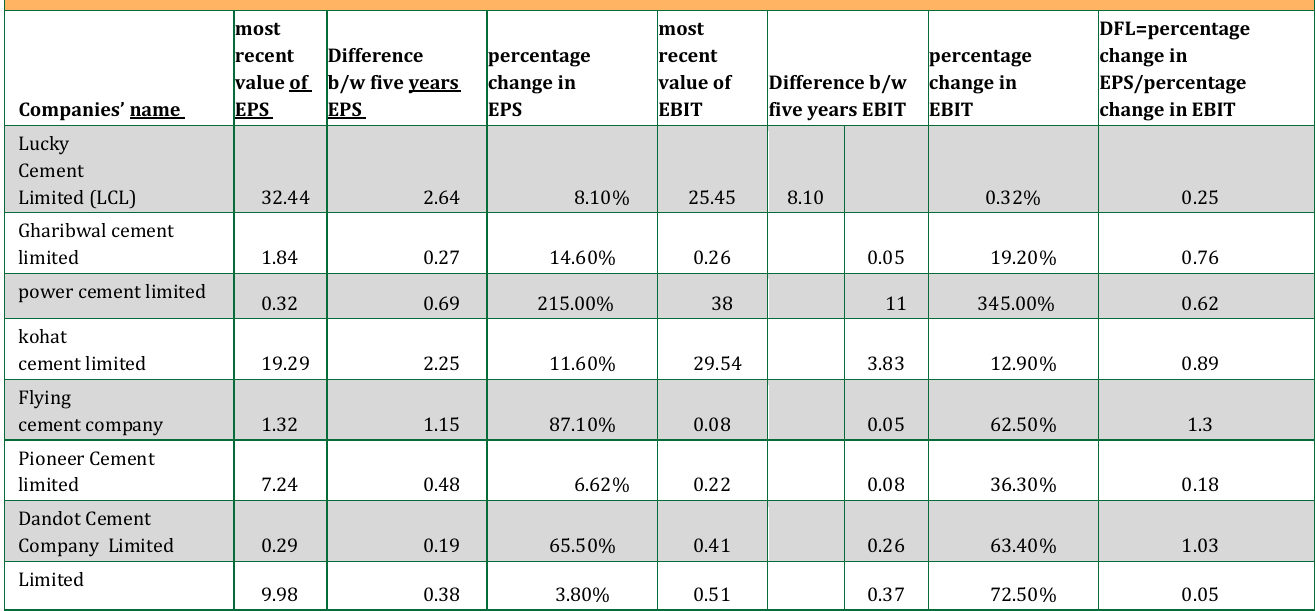
Table 2: Calculation of degree of financial leverage